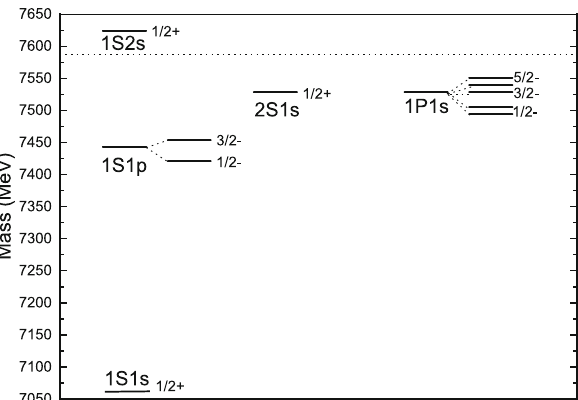
Fig. 4 Mass spectrum (in GeV) of the (cid:2) (cid:2) Fig. 7 Mass spectrum (in MeV) of the (cid:3) bc baryons, corresponding to baryons, corresponding to bc the Table 16. The horizontal dashed line shows the (cid:4) b D threshold the Table 15. The horizontal dashed line shows the (cid:4) b D s threshold